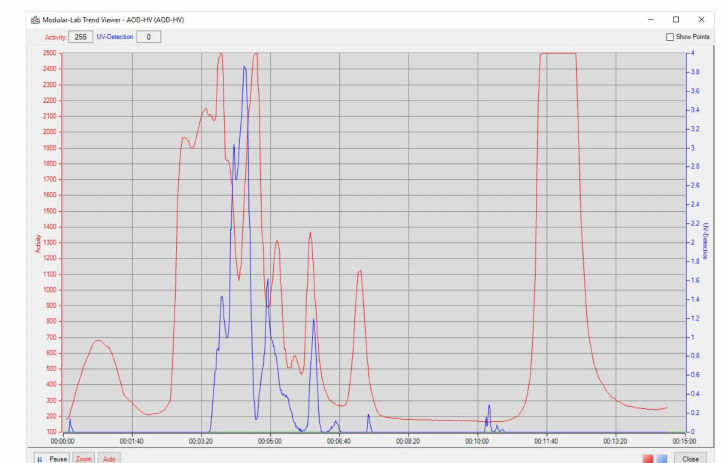
Figure 5. Example diagram for the HPLC separation in the preparation of [ 18 F]GP1with a starting activity of ~100 GBq. The UV channel is shown in blue, the gamma channel in red. The product peak is between 11–14